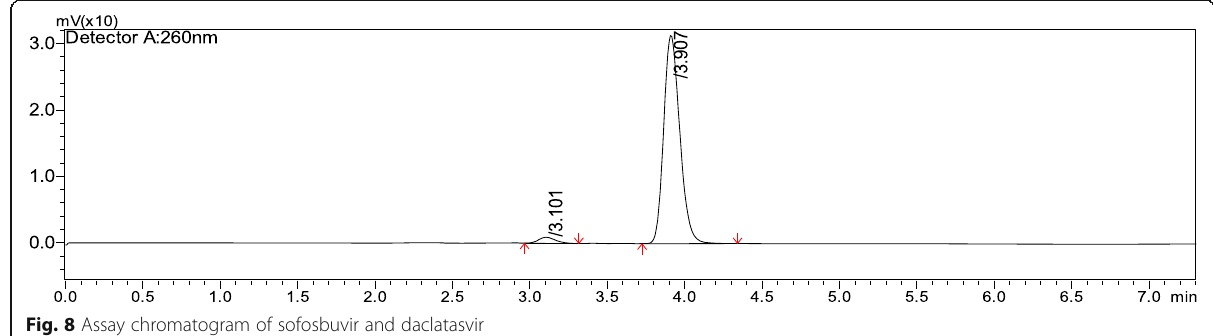
Fig. 8 Assay chromatogram of sofosbuvir and